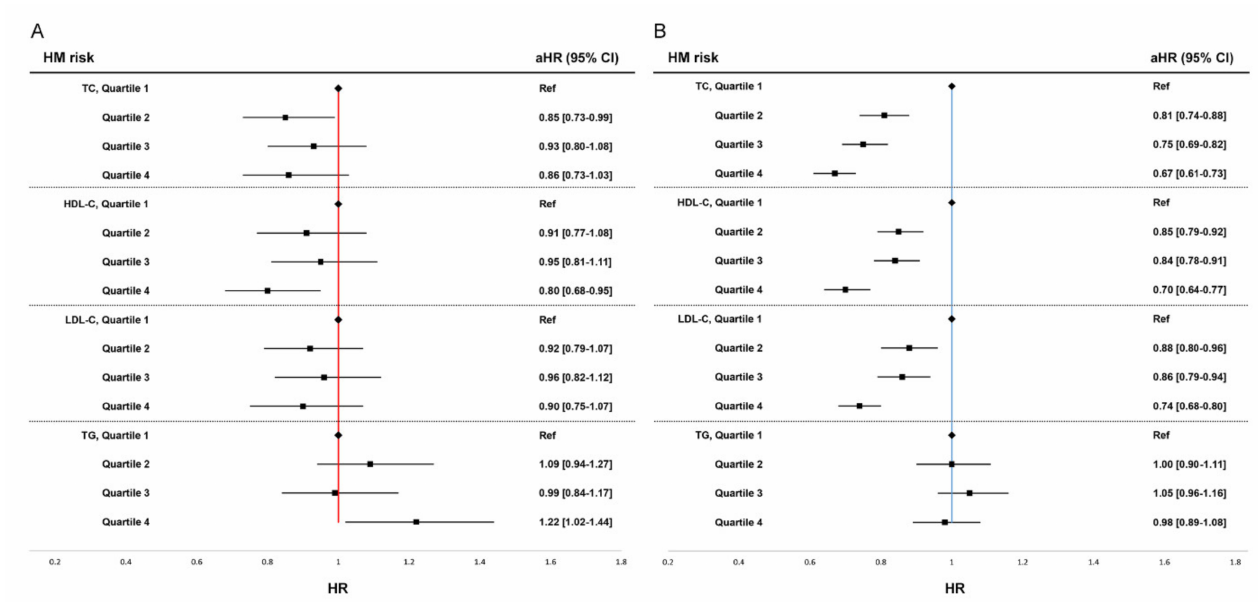
Figure 1. Forest plot of adjusted hazard ratio for overall hematologic malignancy (HM) by quartiles of serum lipid levels. ( A ) Risk of HM in premenopausal women, ( B ) Risk of HM in postmenopausal women. HR, hazard ratio; CI, confidence interval; Pre, premenopausal women; Post, postmenopausal women HRs are adjusted for age, body mass index, smoking, alcohol consumption, regular exercise, diabetes mellitus, and history of taking medication for dyslipidemia within a